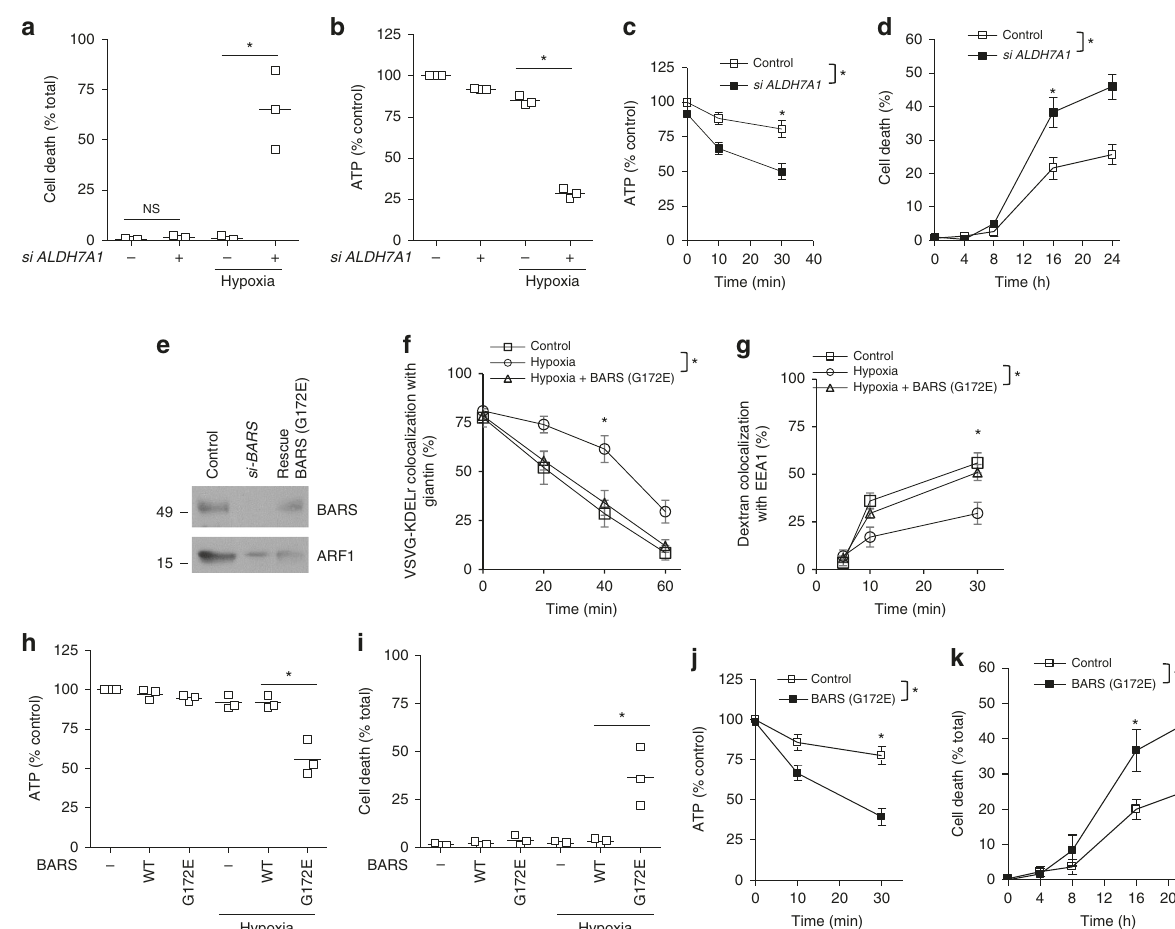
Fig. 7 ALDH7A1 promotes energy homeostasis during hypoxia and starvation. Quantitative results are shown as mean with standard deviation; * p < 0.05, NS not signi fi cant, paired two-tailed Student ’ s t -test. Source data are provided as a Source Data fi le. a HeLa cells were treated as indicated, and then cell death was quanti fi ed; n = 3 independent experiments. b HeLa cells were treated as indicated, and then total ATP level was quanti fi ed; n = 3 independent experiments. c Starved HeLa cells were treated as indicated, and then total ATP level was quanti fi ed; n = 3 independent experiments. d Starved HeLa cells were treated as indicated, and then cell death was quanti fi ed; n = 3 independent experiments. e Immunoblotting of HeLa cell lysates showing the ef fi cacy of siRNA against BARS, and the level of mutant BARS expressed for rescue studies; n = 2 independent experiments with a representative result shown. f